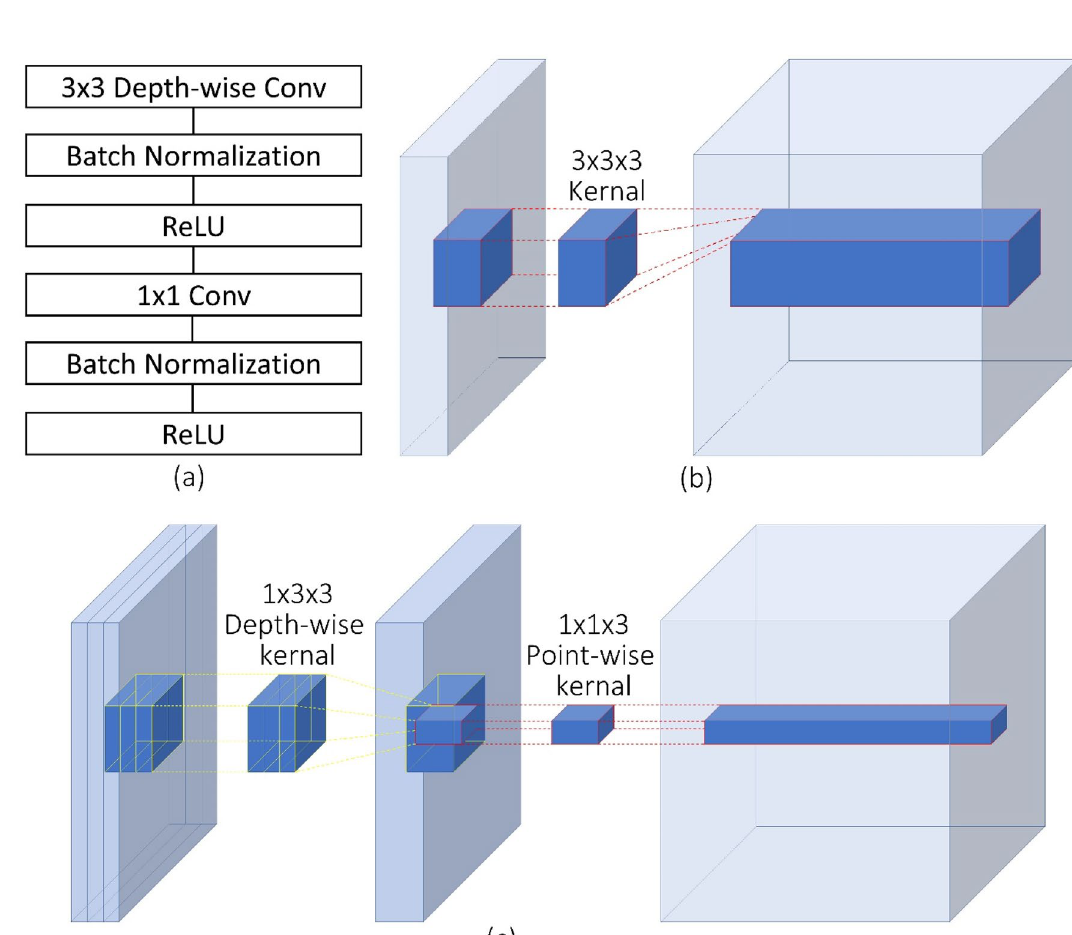
Figure 3. ( a ) A depth-separable convolution block. The block contains a 3 × 3 depth-wise convolutional layer and a 1 × 1 point-wise convolution layer. Each convolutional layer is followed by batch normalization and Relu6 activation. ( b ) An example of a convolution layer with a 3 × 3 × 3 kernel. ( c ) An example of a depth-wise separable convolution layer equivalent to ( b